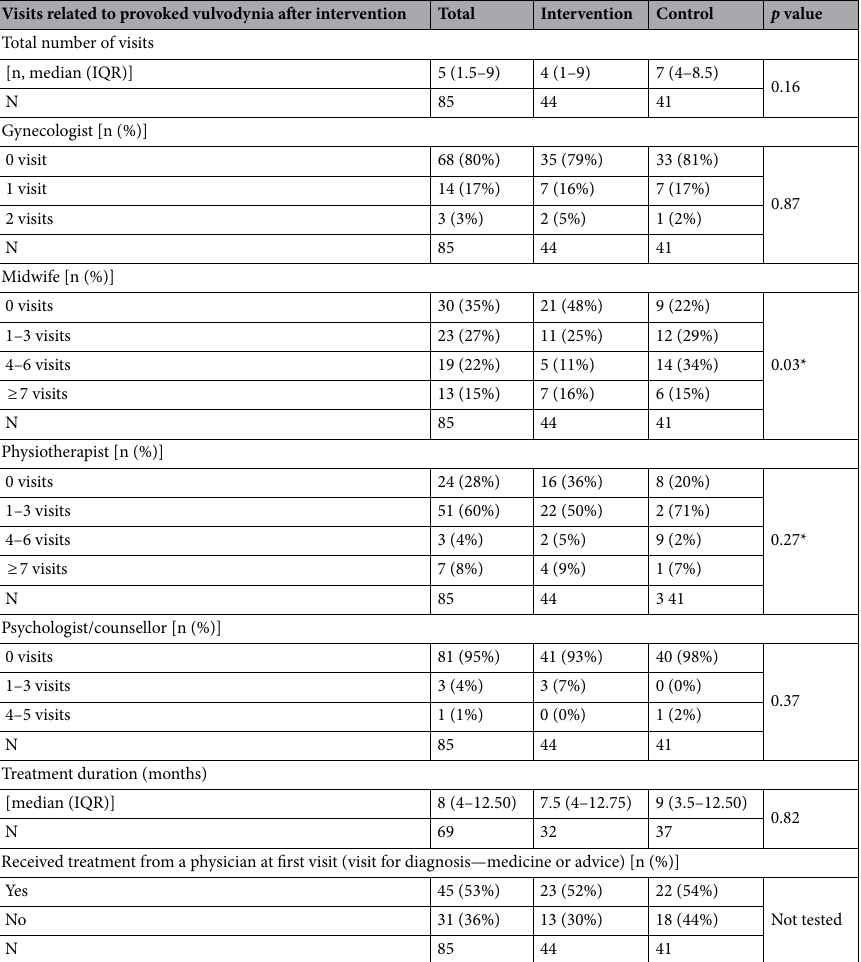
Table 2. Contact with healthcare due to provoked vulvodynia. *Mann–Whitney’s test for categorized data.